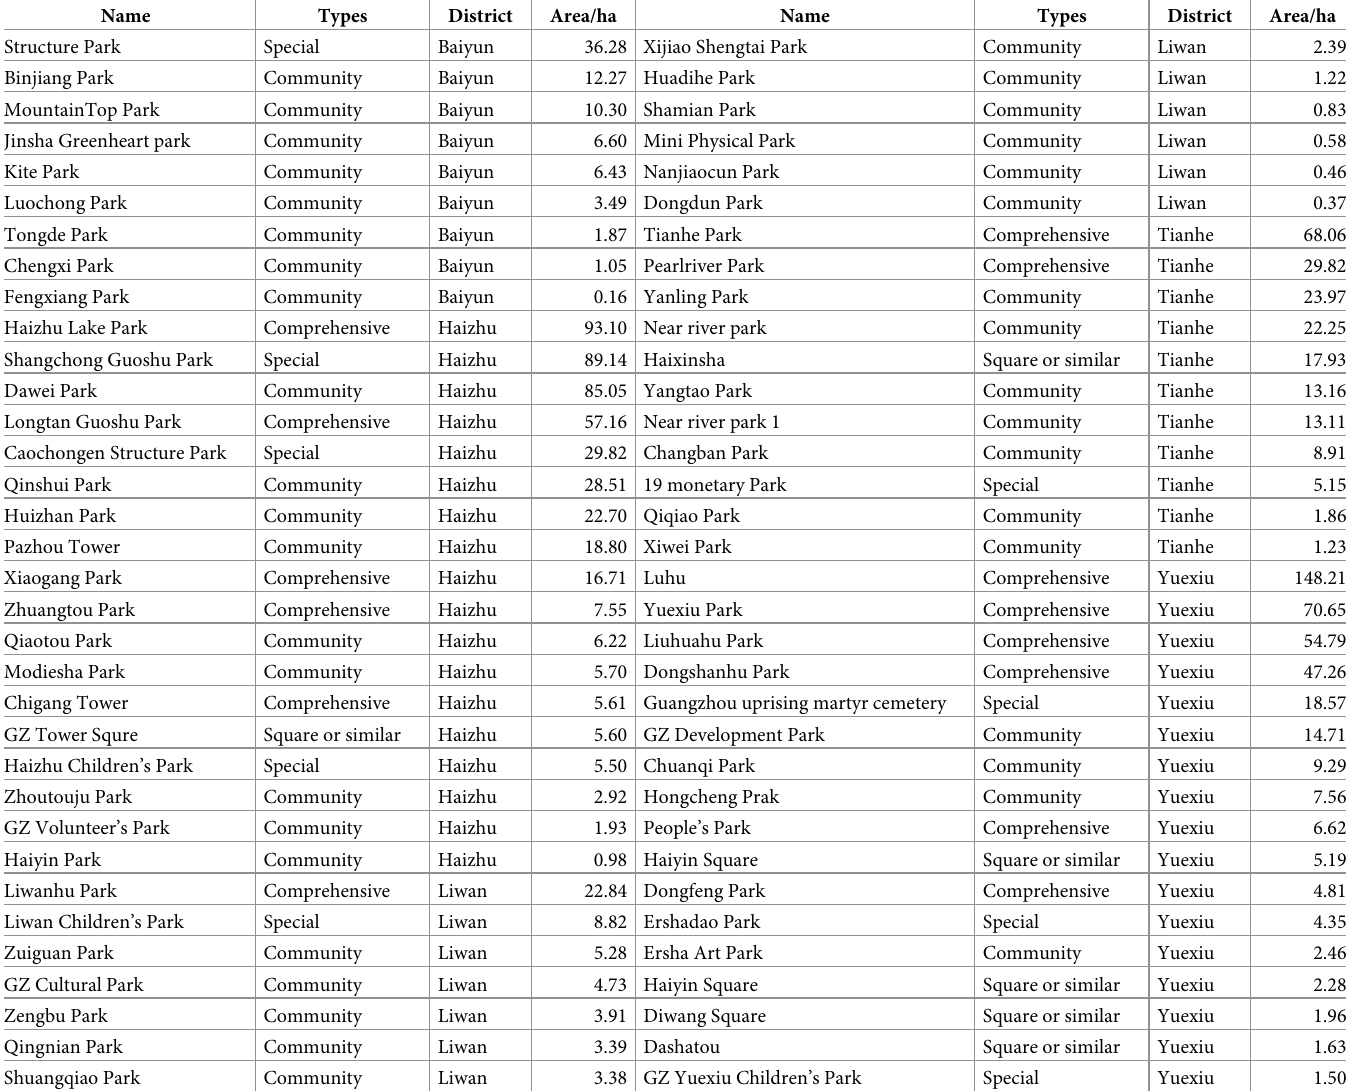
Table 1. The information of public parks in